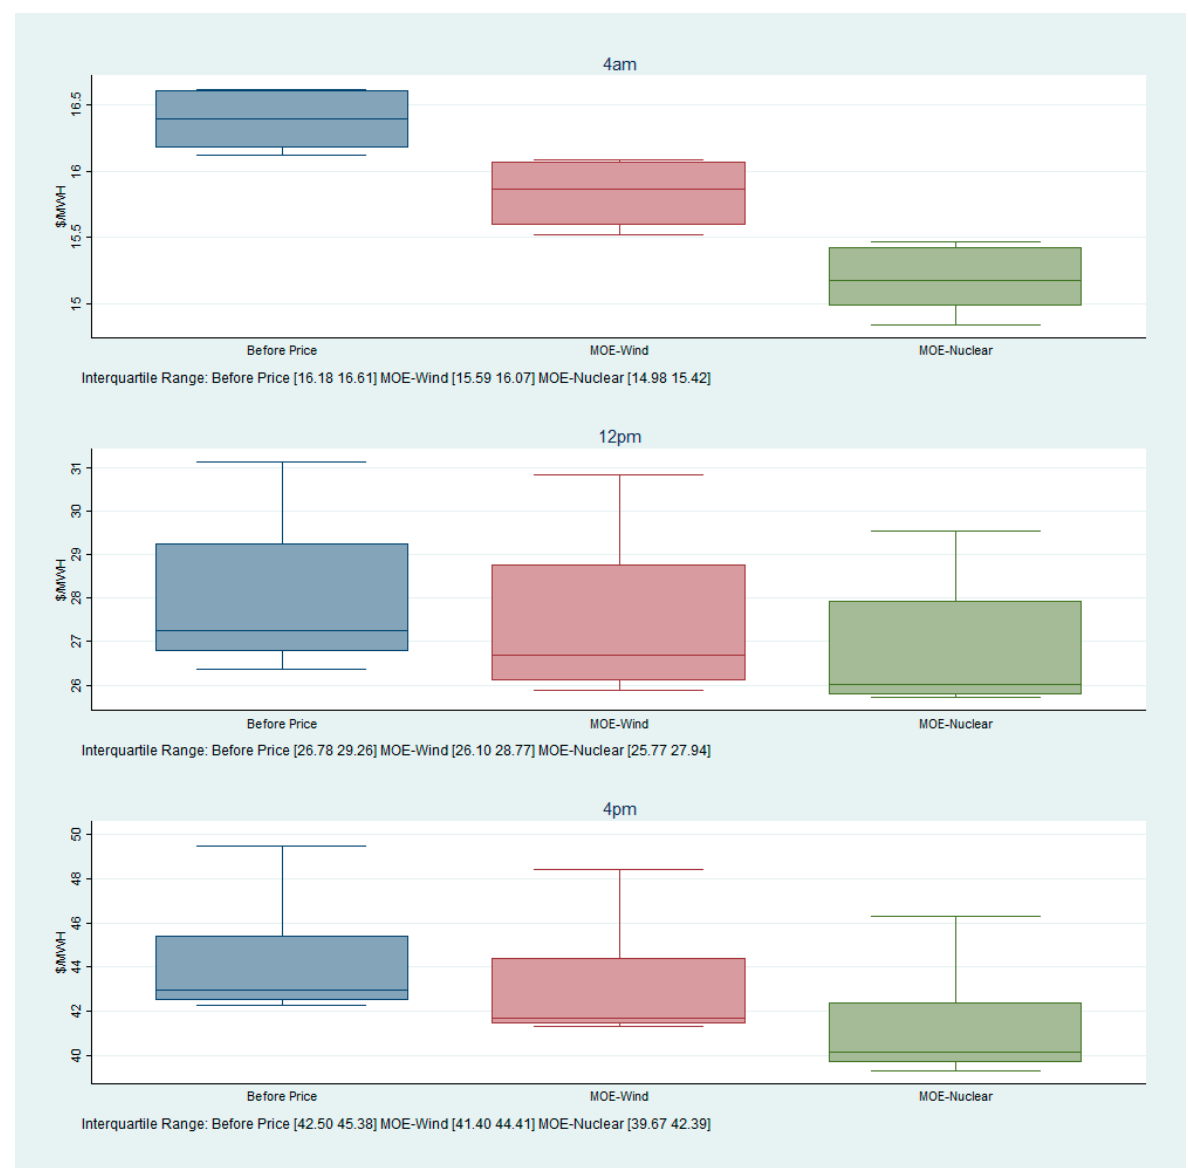
Figure 7. ERCOT merit-order effects for wind and nuclear generation.